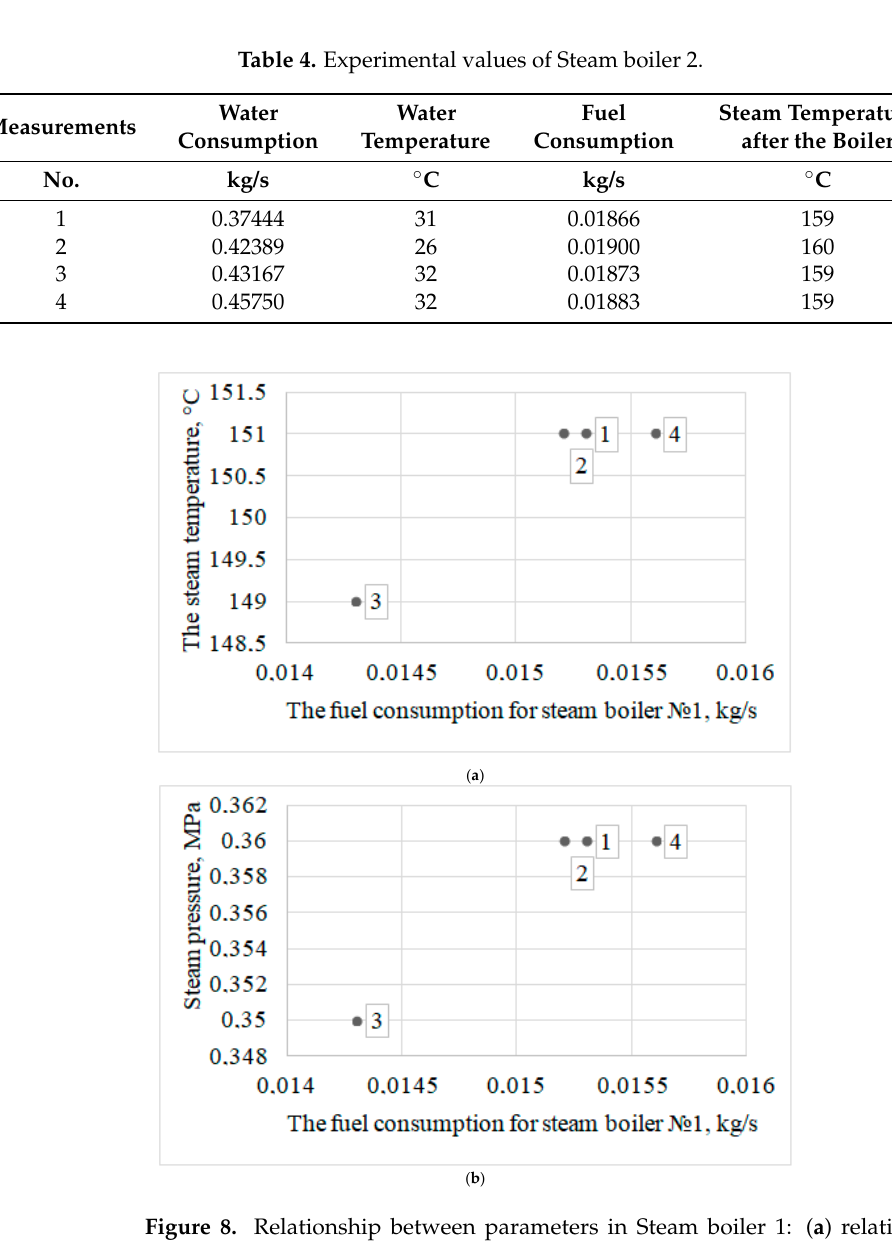
Figure 8. Relationship between parameters in Steam boiler 1: ( a ) relationship between steam temperature and fuel consumption, ( b ) relationship between steam pressure and fuel. The correlation coefficient showing the relationship between the steam temperature and the fuel consumption for steam boiler No. 2 is 0.89, which indicates a sufficient rela ‐ tionship of these values. A positive correlation indicates that an increase in one value contributes to an increase in another, Figure 9.